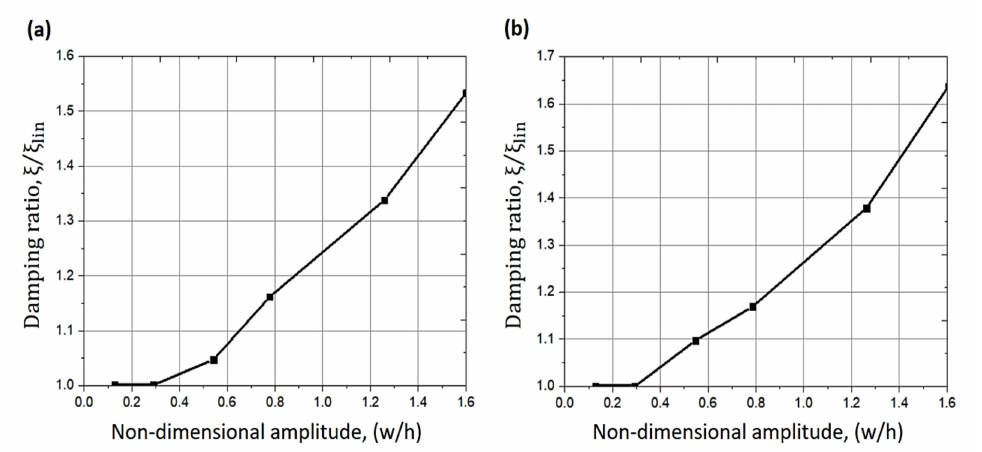
Figure 7. Changes of damping ratio with respect to the amplitude of vibration ( a ) using model 1, ( b ) using model 2